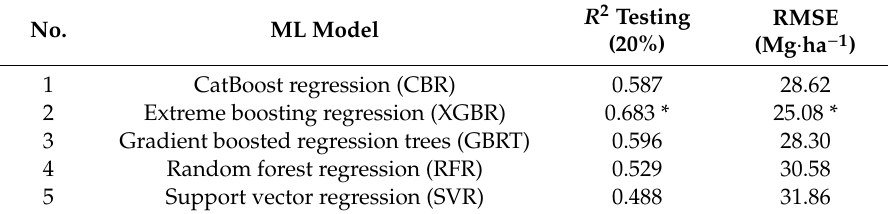
Table 8. Comparison of the model performances using new predictor variables based on the